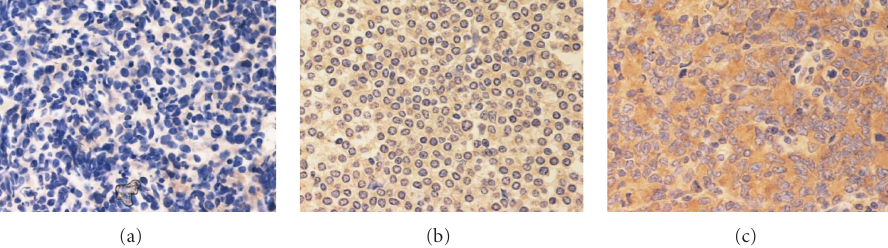
Figure 1: Immunohistochemical stains of lymphoma tissues (a) negative, (b) weakly positive, and (c) strongly positive.